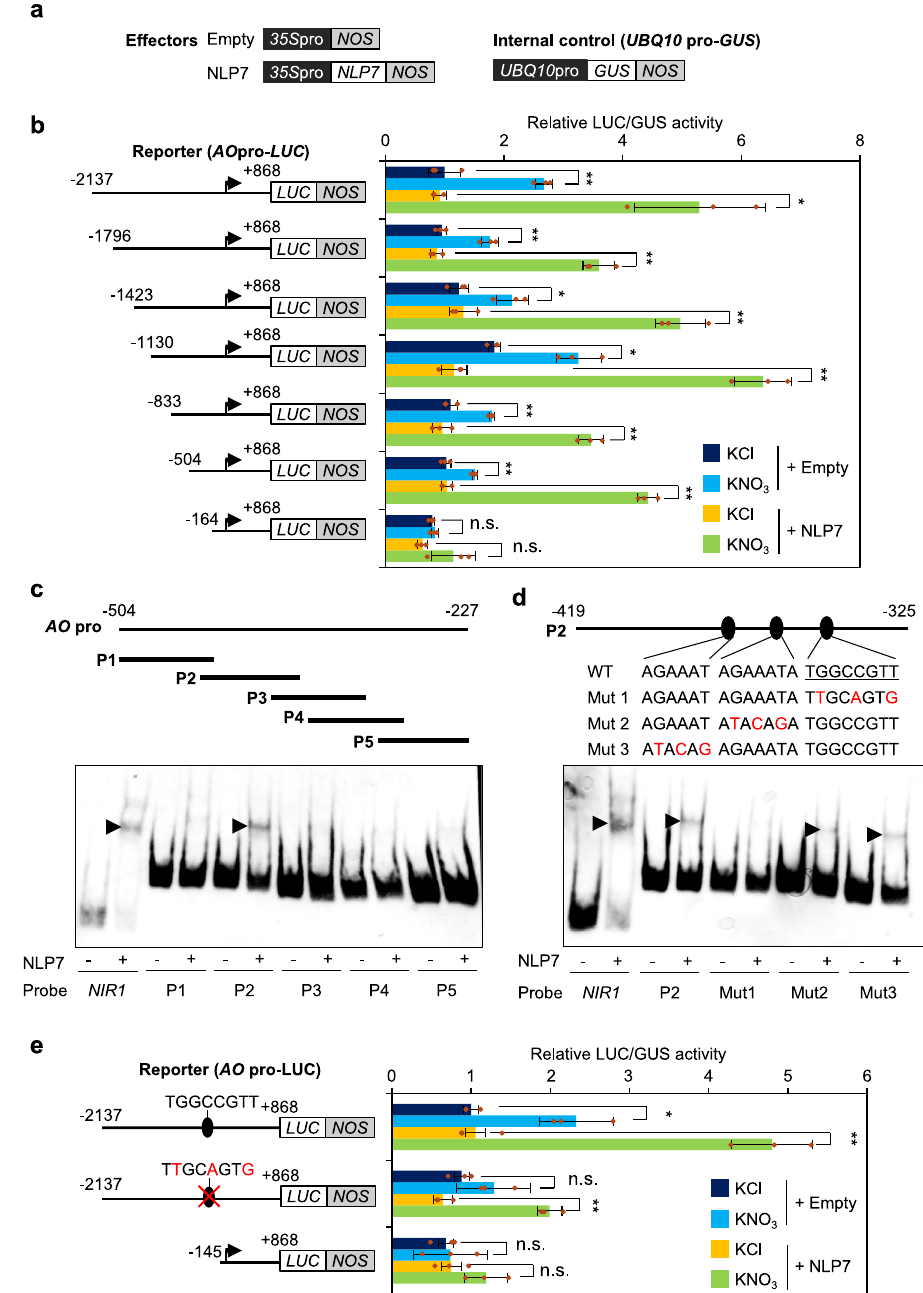
Fig. 2 Nitrate-dependent activation of the AO promoter through the speci fi c binding of NLP7. a Effector and internal control plasmids. The effector plasmid contains NLP7 cDNA cloned between the modi fi ed 35 S promoter ( 35S pro) and the NOS terminator ( NOS ), while the empty vector contained no DNA insert. The plasmid carrying the GUS gene under the control of the UBQ10 promoter ( UBQ10 pro) served as an internal control. b Co-transfection assay. Protoplasts from N-starved plants were co-transfected with a reporter plasmid (expressing the luciferase gene ( LUC ) under the control of a truncated fragment of the AO promoter), NLP7 expression vector or the empty vector, and the internal control plasmid, and then incubated in the presence of 10 mM KNO 3 or KCl (control). The transcription start sites are indicated by arrows. c , d Electrophoretic mobility shift assay (EMSA). DNA probes corresponding to different regions of the AO promoter (P1 – P5) in ( c ) and the WT and mutant P2 probes in ( d ) were incubated in the presence ( + ) or absence (-) of recombinant NLP7. The mutant P2 probes (Mut1, Mut2, and Mut3) contained nucleotide substitutions (as indicated). A DNA fragment from the NIR1 promoter was used as a positive control. Black arrowheads indicate retarded bands. e Activation of the AO promoter, depending on both the NLP7- binding site and NLP7. Reporter plasmids contained the WT or mutated AO promoter. The AO promoter truncated at -1,015 was used as a negative control. Nucleotide substitutions in the mutated AO promoter were the same as those in the Mut1 probe. In ( b ) and ( e ), data represent mean ± SD ( n = 3), and relative LUC activity obtained from protoplasts co-transfected with the reporter plasmid (containing the full-length WT AO promoter) and the empty vector, and then incubated in the presence of 10 mM KCl, was set to 1. Asterisks indicate signi fi cant differences between seedlings treated with and without nitrate (Welch ’ s t -test; * P ≤ 0.05, ** P ≤ 0.01). n.s. not signi fi